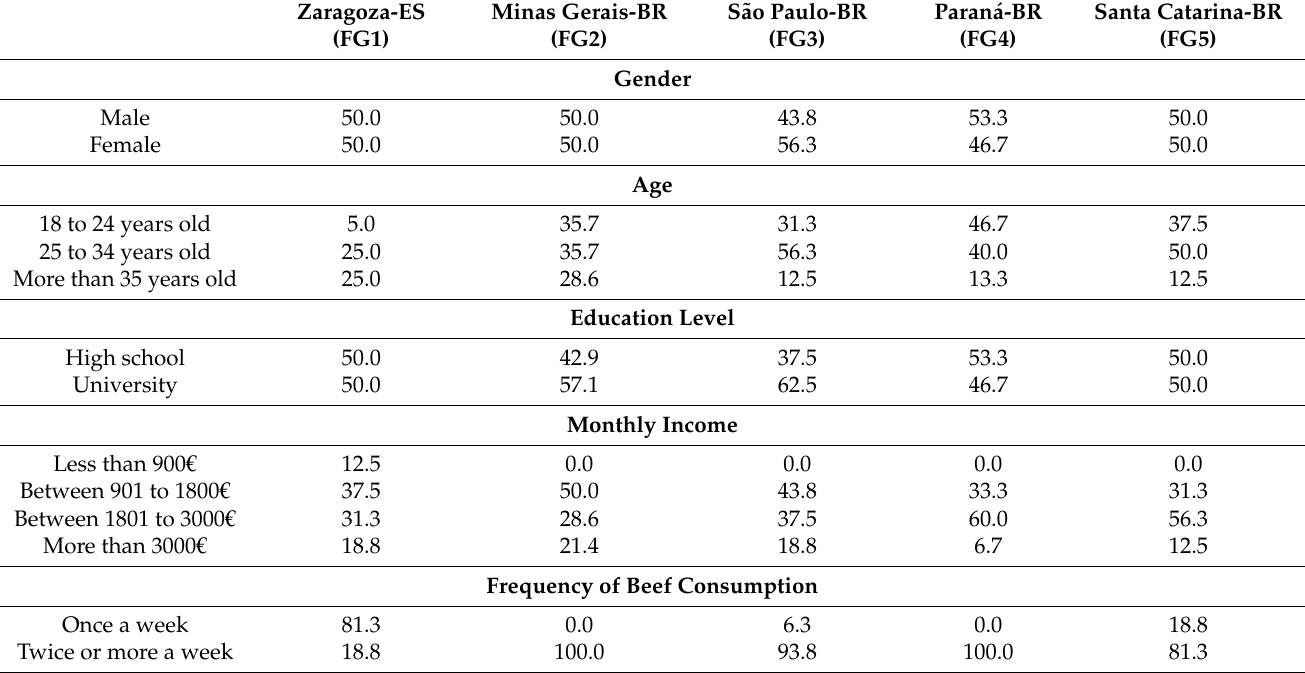
Table 2. Frequency of socioeconomic data of the interviewees/interview location